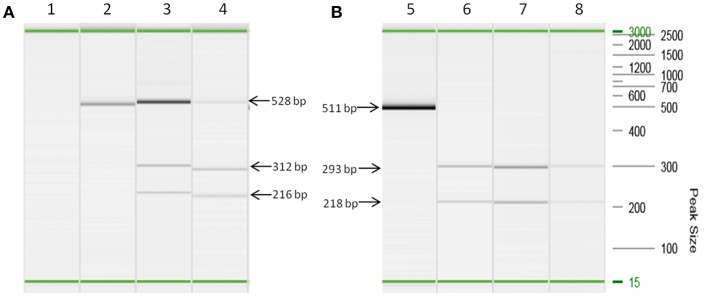
Strain typing of directly isolated DNA deriving from tissue and fecal samples based on a PCR-restriction endonuclease analysis genotyping assay (21). (A) Lanes 2, 3, and 4 are PCR amplicons of snp3842359 (for C-type and S-type MAP differentiation) from DNA extracts of lymph node tissues (lane 3) and fecal sample (lane 4) restricted with BsmB I. Lane 2 corresponds to culture isolate MAP ATCC 19698, which remains undigested by BsmB I corresponding to the pattern of a C-type genotype. Lane 1 is a negative control. (B) Lanes 5, 6, 7, and 8 are PCR amplicons of snp343677 (for S-type I and III differentiation) from DNA extracts of lymph node tissues (lane 6), intestine tissues (lane 7) and fecal sample (lane 8) restricted with Ava II. Lane 5 is the undigested PCR amplicon of a S-type MAP strain. All PCR reactions were performed using prediluted DNA extracts (1:5 dilution) in order to prevent inhibition of PCR. On the right hand side the DNA size marker (100 bp−2.5 kb) is represented. In each capillary electrophoresis run an alignment marker of 15 bp and 3,000 kb was loaded representing the start and end of electrophoresis. Visible minor differences of apparent size of PCR products are artifacts because PCR reactions have been carried out at different days. Therefore, this figure illustrates a merged picture of several capillary electrophoresis runs. Fragment sizes of PCR products and restriction products, respectively, indicated by arrows apply to all corresponding visible bands.